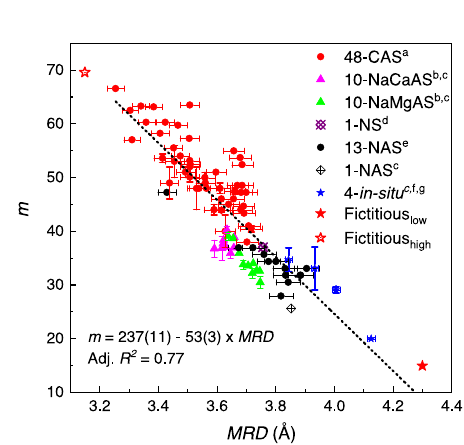
Fig.5|Inverselinearcorrelationbetween m and MRD valuesfor89glasses. The MRD valuesof48CASglasses(redcircles)werecalculatedusingthelinearequation between MRD andSiO 2 mol%contentobtainedinFig.2a.The MRD valuesof10NAS glasses (black circles) were calculated using the equation, as shown in Fig. 4e. The MRD values of all other glasses were derived from the measured FSDPs of neutron structure factors. The error bars of calculated MRD values were propagated from errors in the linear equations. The error bars of measured MRD values are approximatelythesamesizeasthesymbols.Thedottedlineisalinear fi tofthedata for 89 glasses, with R 2 =0.77. a : see the resources of Fig. 1; b : ref. [29], c : ref. [30], d